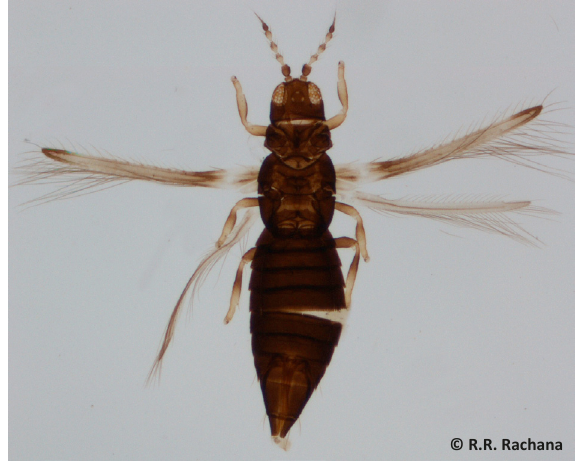
Image 1. Female Caliothrips